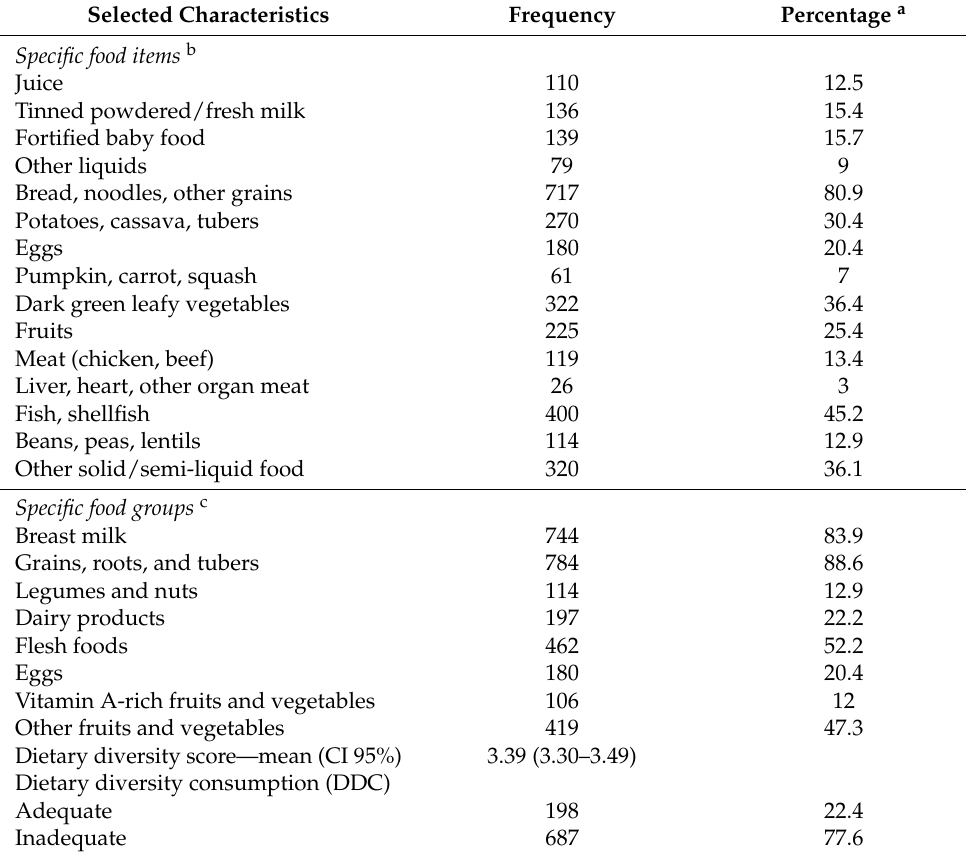
Table 3. Frequency and percentage of children’s consumed specific food items, food groups, dietary diversity from the Ghana Demographic and Health Survey